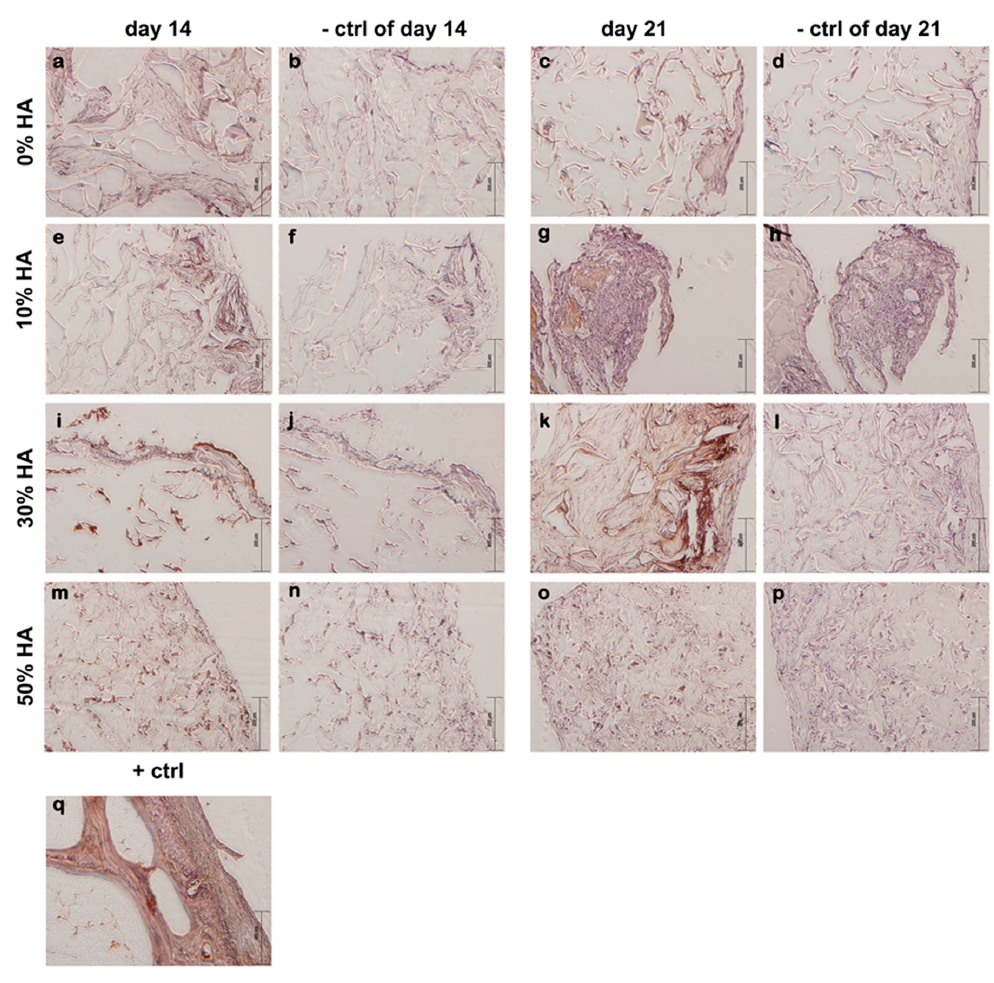
Figure 6. Immunohistochemical staining with anti-ostecalcin. Brown color indicates positive staining. Weak staining is observed in samples with 0% HA ( a , c ) and 50% HA ( m , o ). Very strong staining was observed in scaffold composed of 30% HA after 21 days of osteoinduction ( k ). Moderate staining for osteocalcin was shown for scaffold with 10% HA ( e , g ) as well as for scaffold 30% HA scaffold after 14 days of dynamic culture ( i ). As negative controls ( − ctrl of day 14 and − ctrl of day 21), sections were processed for each sample in the absence of the suitable primary antibody ( b , d , f , h , j , l , n , p ). Human bone was used as a sample for positive control (+ctrl) ( q ). Representative images are shown at 100× magnification ( n = 3). Scale bar represents 200 µm.